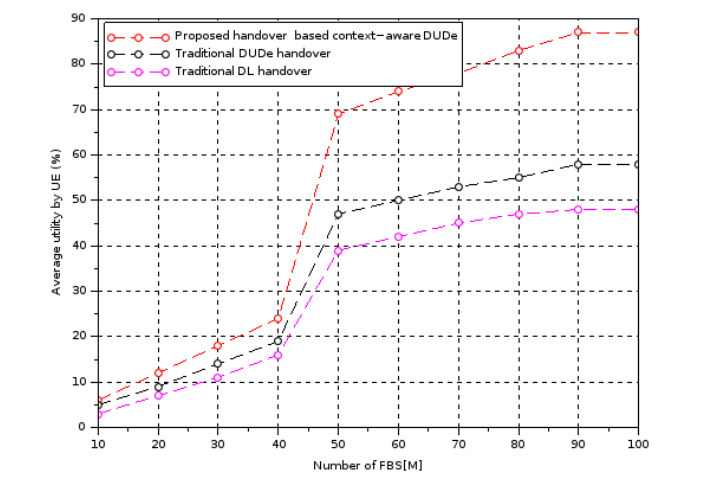
Figure 4. The utility rate for UEs regarding the number of femto BSs (FBSs) M, under the considered approaches ( N = 100